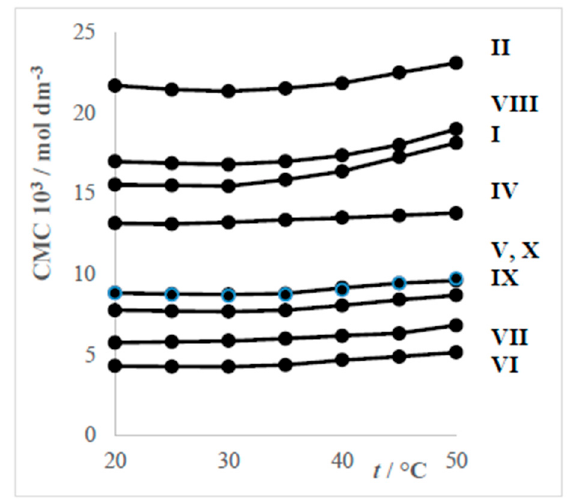
Figure 6. Dependences of CMC on temperature.